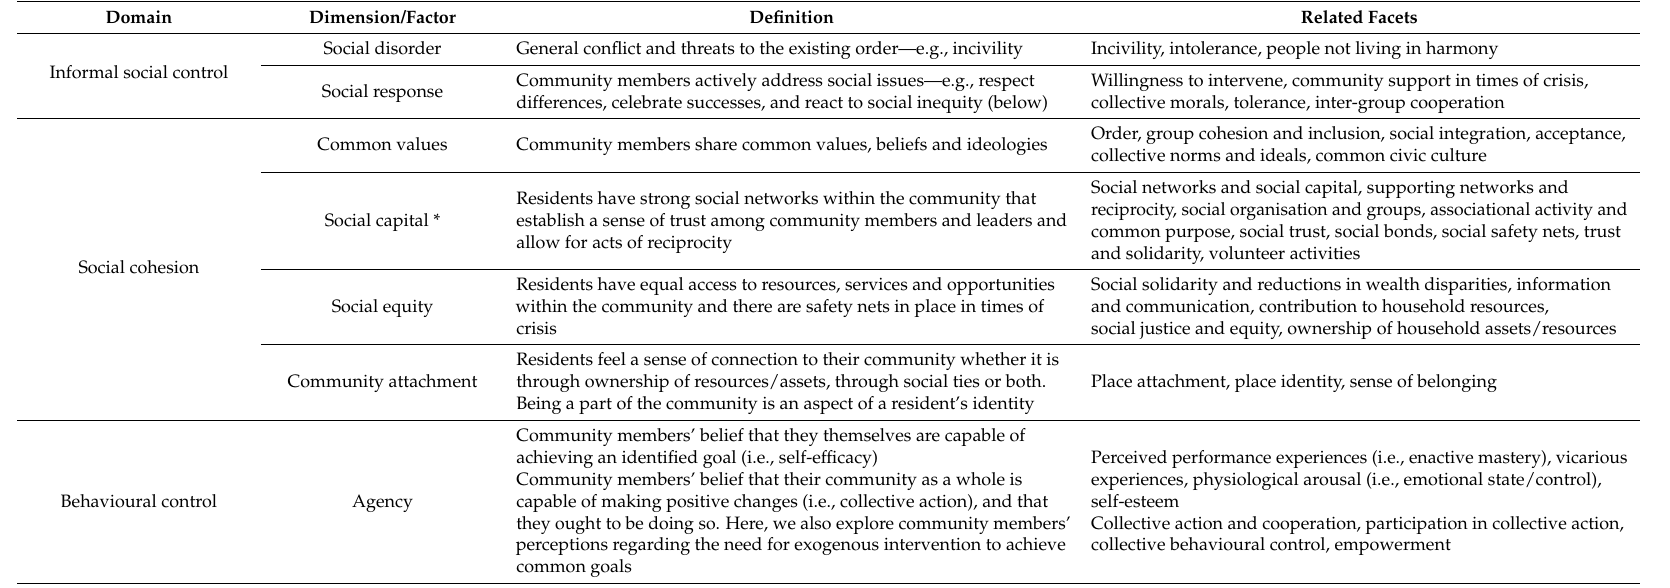
Table 1. Hypothesised collective efficacy